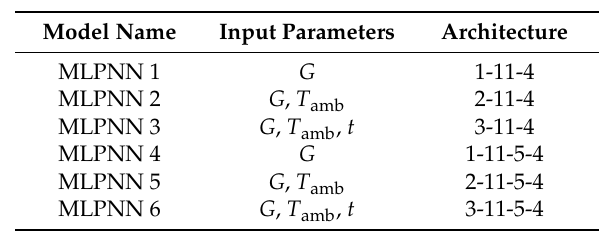
Table 4. Description of the MLPNN